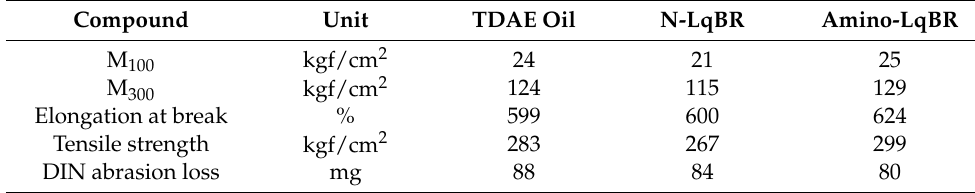
Table 8. Mechanical properties and abrasion resistance of vulcanizates.